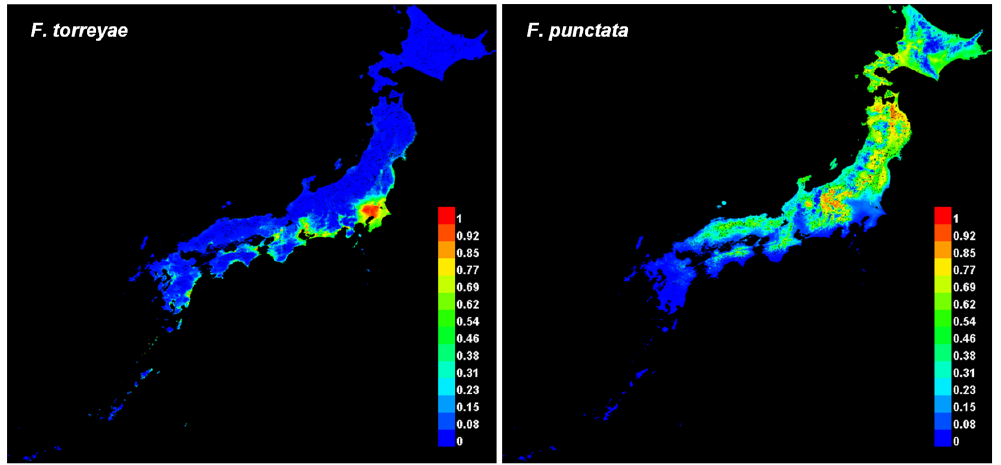
Figure 1. Presence probability of Fomitiporia torreyae and Fomitiporia punctata predicted by Maxent. The vertical scale bar indicates the mean of the probability (100 bootstrap replicates) from 0 (blue, low probability) to 1 (red, high).